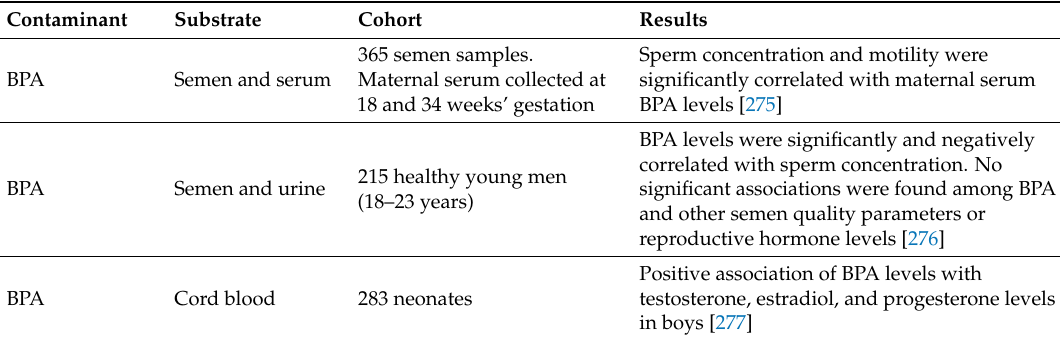
Table 4. Recent evidences on the effects of EDCs on fertility in